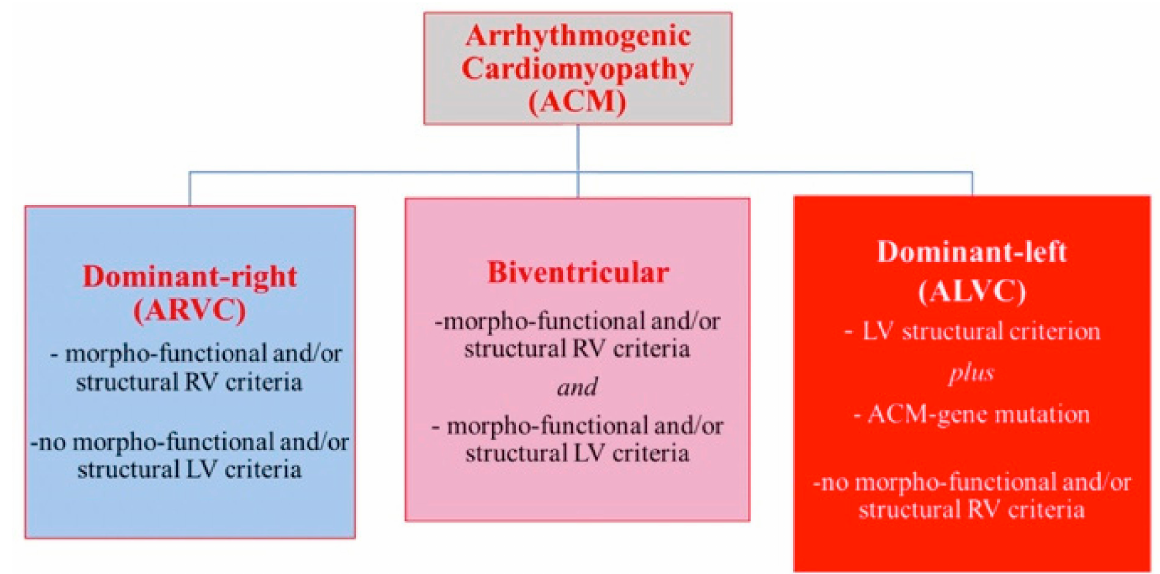
Figure 4. Diagnosis of phenotypic variants of ACM in patients fulfilling the Padua criteria. Demonstration of morpho- functional and/or structural ventricular abnormalities is required for diagnosis of each phenotypic variant of ACM. Although right-ventricular dominant (ARVC) and biventricular disease variants can be diagnosed in those patients fulfilling RV and LV phenotypic criteria, the diagnosis of left-ventricular dominant (ALVC) disease, without clinically demonstrable RV abnormalities, needs demonstration of an ACM-causing gene mutation, in association with a consistent LV phenotype. Adopted from Corrado D, Perazzolo Marra M, et al. Diagnosis of arrhythmogenic cardiomy left side dilated hearts opathy: The Padua criteria. Int. J. Cardiol.